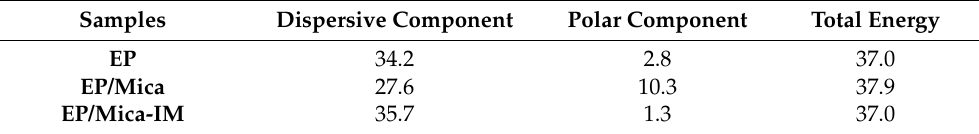
Table 3. The theoretically calculated values of surface free energy of the studied samples.